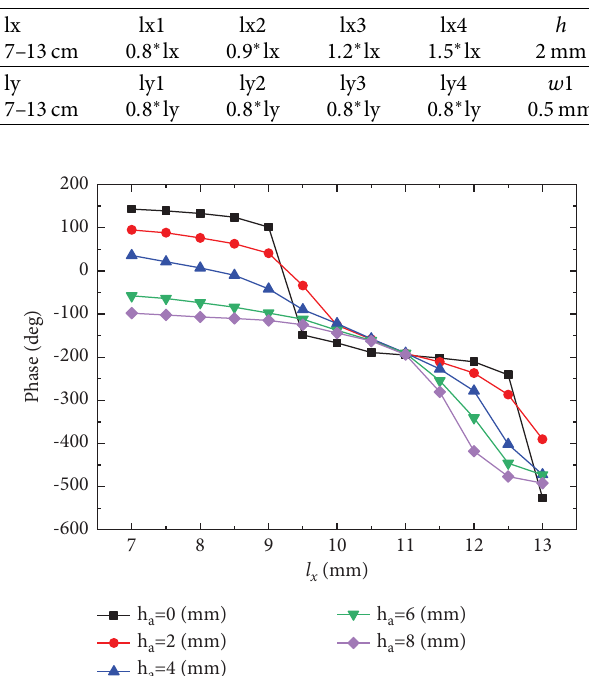
Figure 2: Optimization of air layer thickness.